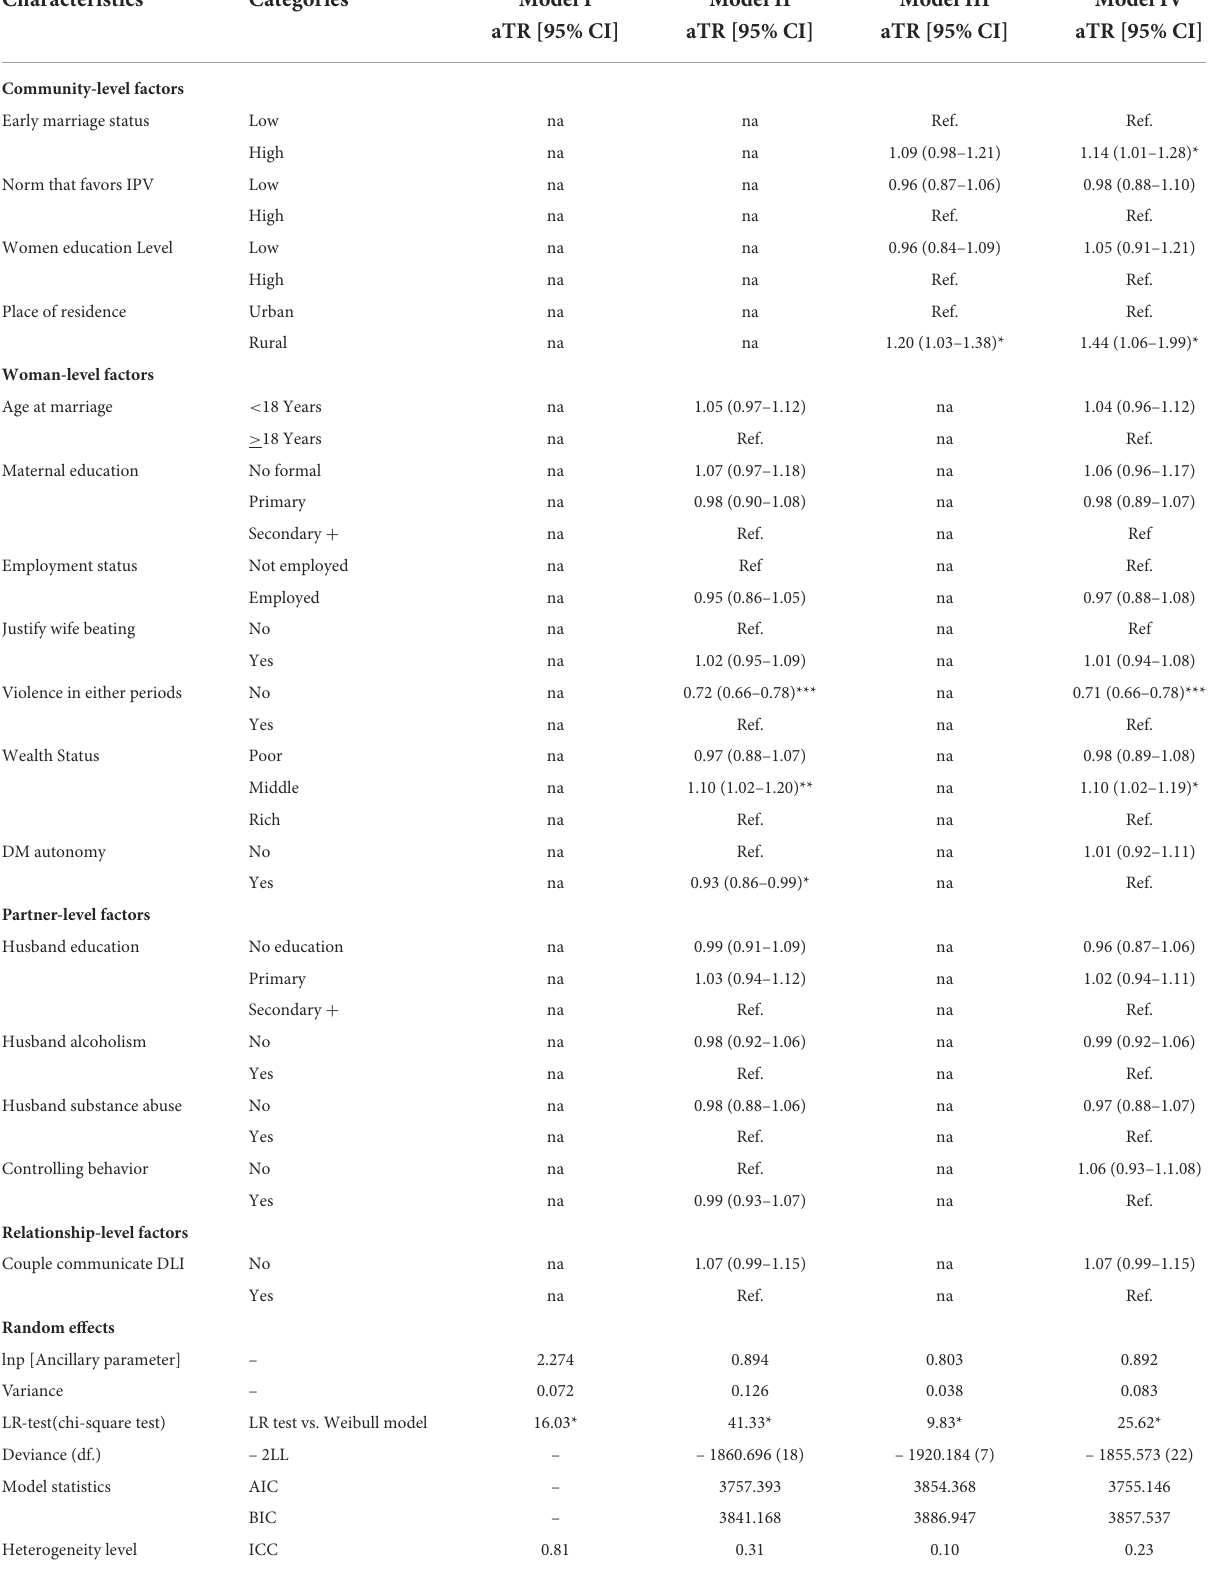
TABLE 5 Multivariable multilevel survival analysis of the postpartum contraceptive use timing among married women ( n = 776).